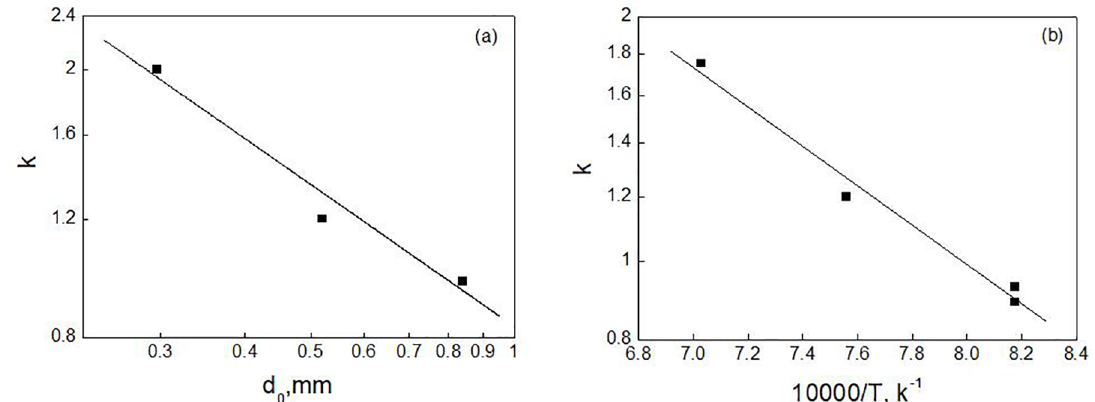
Figure 5. Relationship of n with initial grain size (a) and annealing temperature